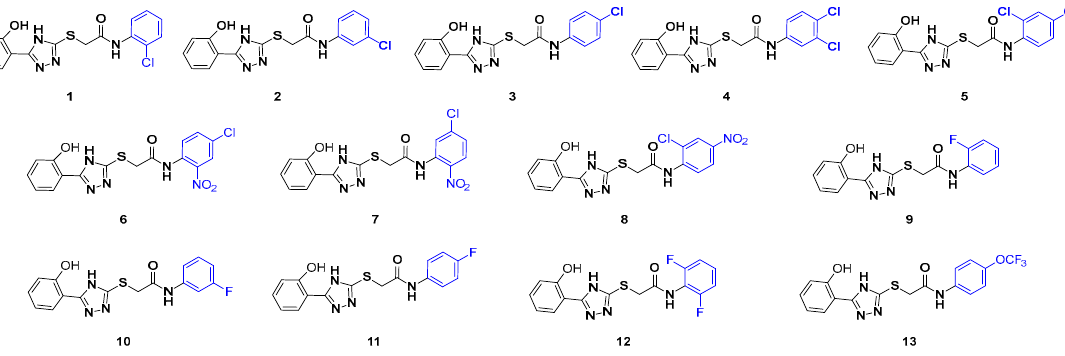
Figure 1. The halogen-substituted triazolethioacetamides.